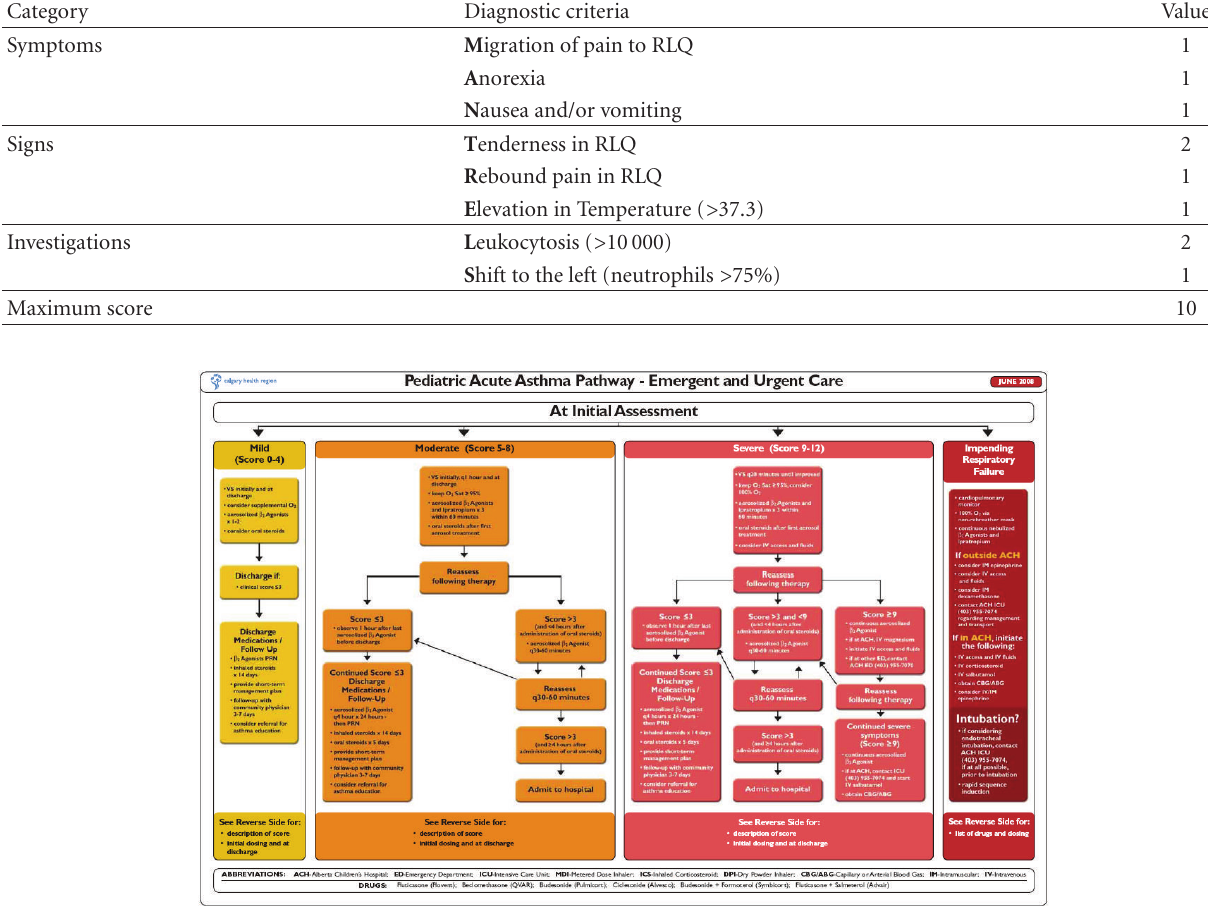
Table 1: The Alvarado Score. Note the MANTRELS acronym in bold. RLQ: Right Lower Quadrant. Category